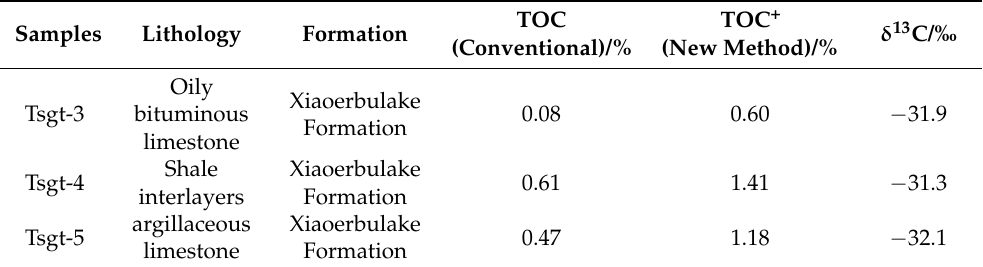
Figure 3. Organic carbon isotopic composition of carbonate source rocks from different regions. Table 3. Organic-matter abundance and carbon isotope measurements of carbonate rocks of the Xiaoerbulake Formation from the Sugaitbulak Outcrop, Tarim